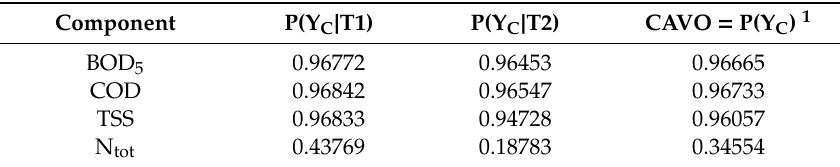
Table 5. Complex operational availability of modeled AS plant.